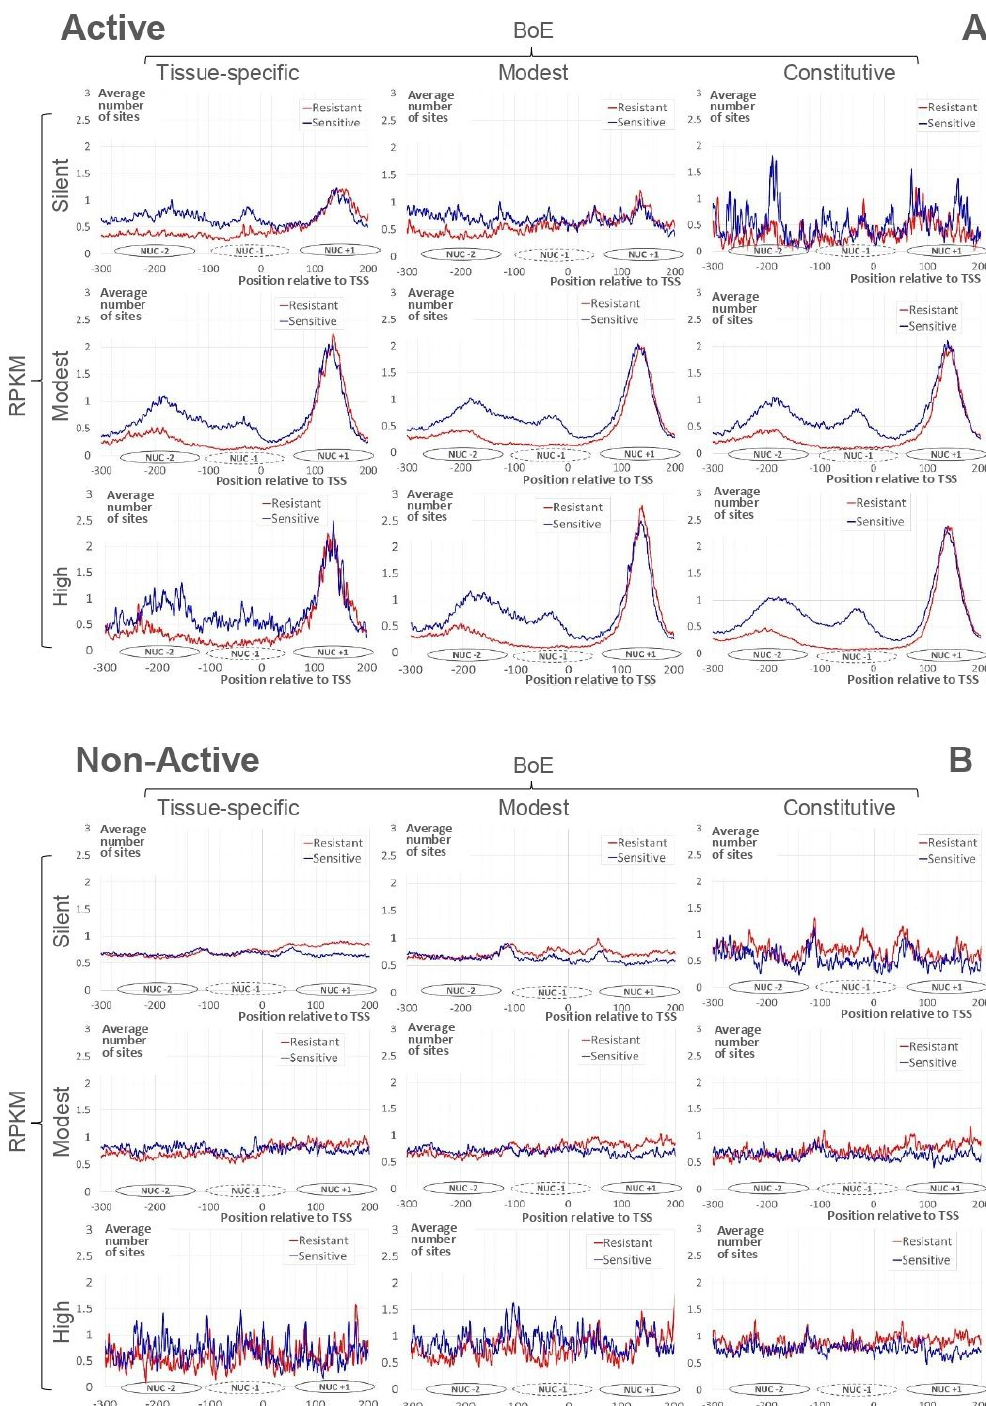
Figure 2. Average numbers of mapped nucleosome sites for “Active” ( A ) and “Non-Active” ( B ) genes (see Section 4). Red / blue lines mark resistant / sensitive nucleosomes [21]. X axes denote the position relative to TSS. Y axes show the moving mean over a window of 3 nt for average number of nucleosome sites. The headers of columns / rows mean the classification of genes by BoE / RPKM. Ovals near X axes denote approximate positions of nucleosomes upstream (Nuc − 2, Nuc − 1) and downstream (Nuc + 1) TSS.